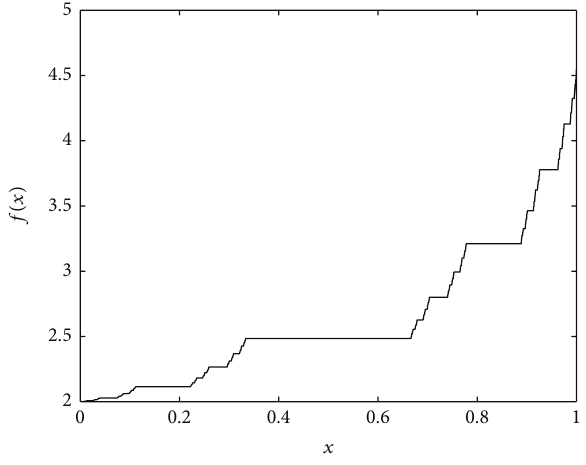
Figure 3: The plot of nondifferentiable solution of (52) with the parameter 𝛼 = ln 2/ ln 3